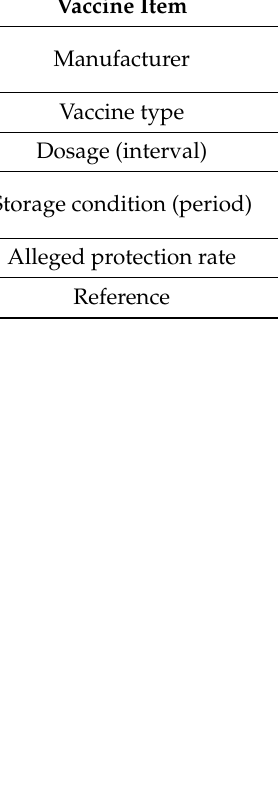
Table 1. Comparison of Pfizer/BNT vaccines, Moderna vaccines, and AstraZeneca vaccines. Vaccine Item Pfizer/BNT Vaccine Moderna Vaccine